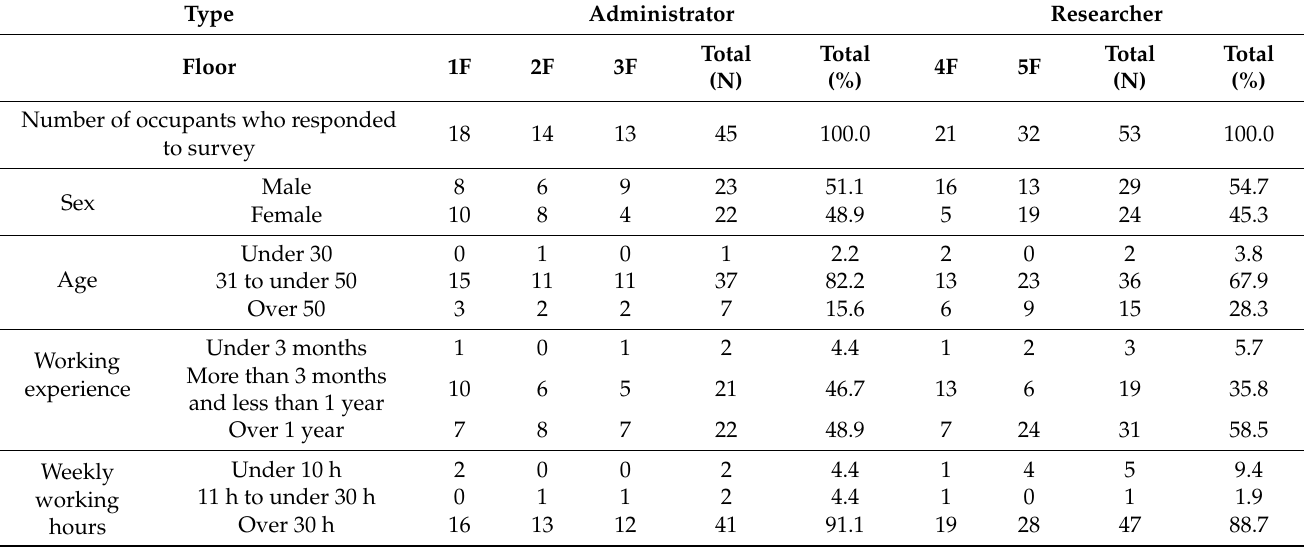
Table 1. Basic information on the administrator and researcher floors.